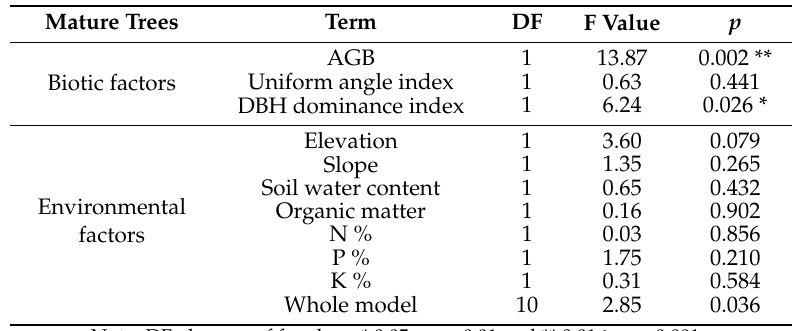
Table A2. Summary of general linear models for the effects of biotic factors and environmental factors on the richness of mature trees.